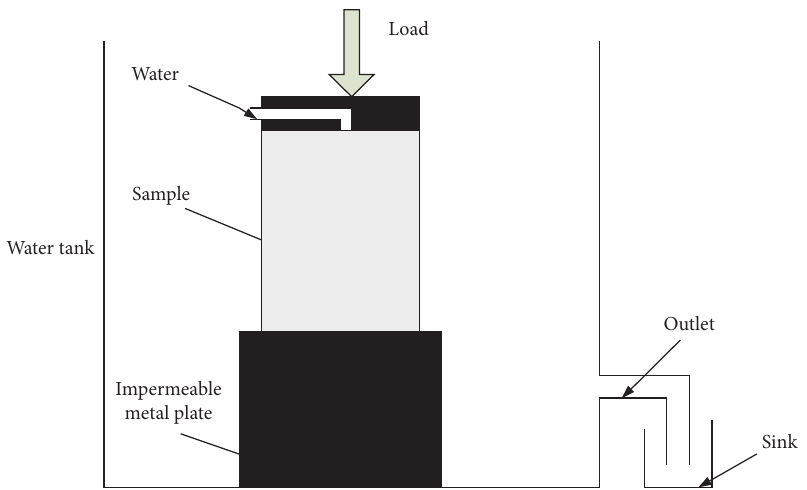
Figure 4: Schematic diagram of the seepage field-stress field coupling test.